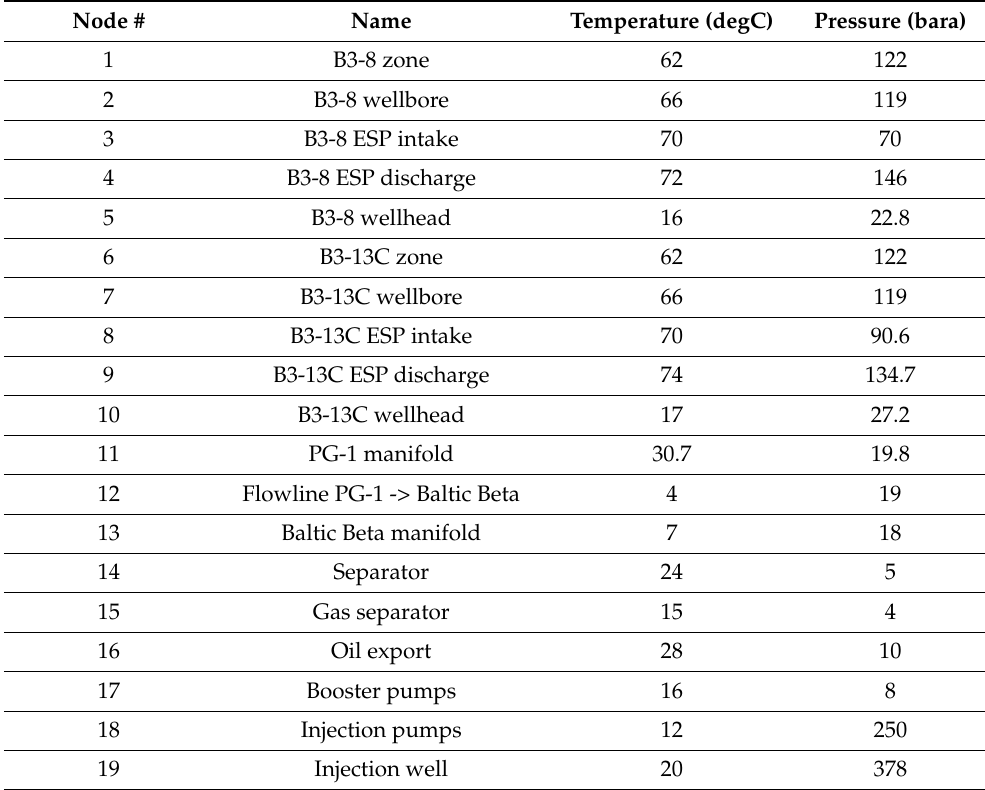
Table 4. Pressure and temperature conditions on critical elements of the upstream production